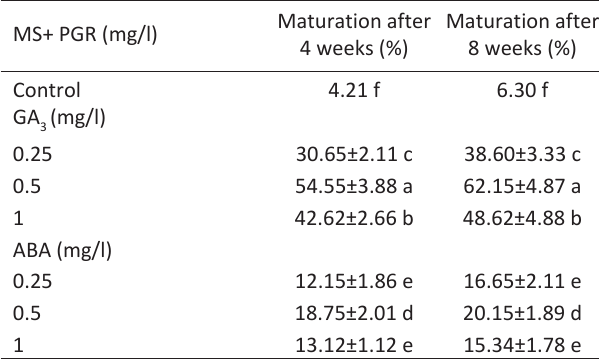
Table 3 - Influence of GA3 and ABA on somatic embryo matura- tion in Gladiolus. Data were scored after 4th and 8th weeks of culture